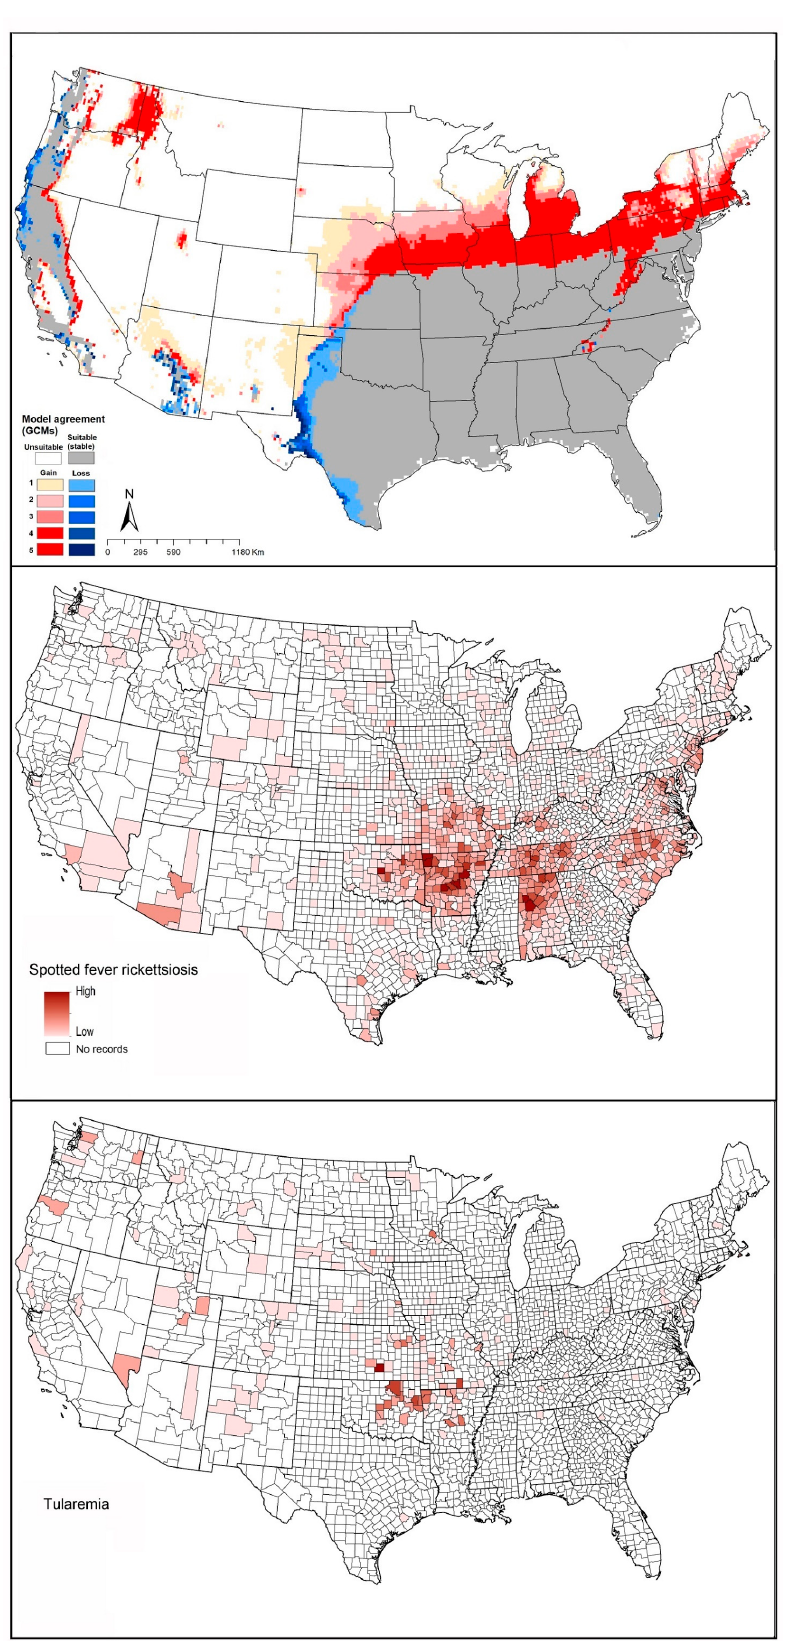
Figure 7. Geographic distribution of Amblyomma maculatum and the diseases that it likely transmits in the United States. Dark pink represents high incidence, light pink indicates low incidence. White represents no records.